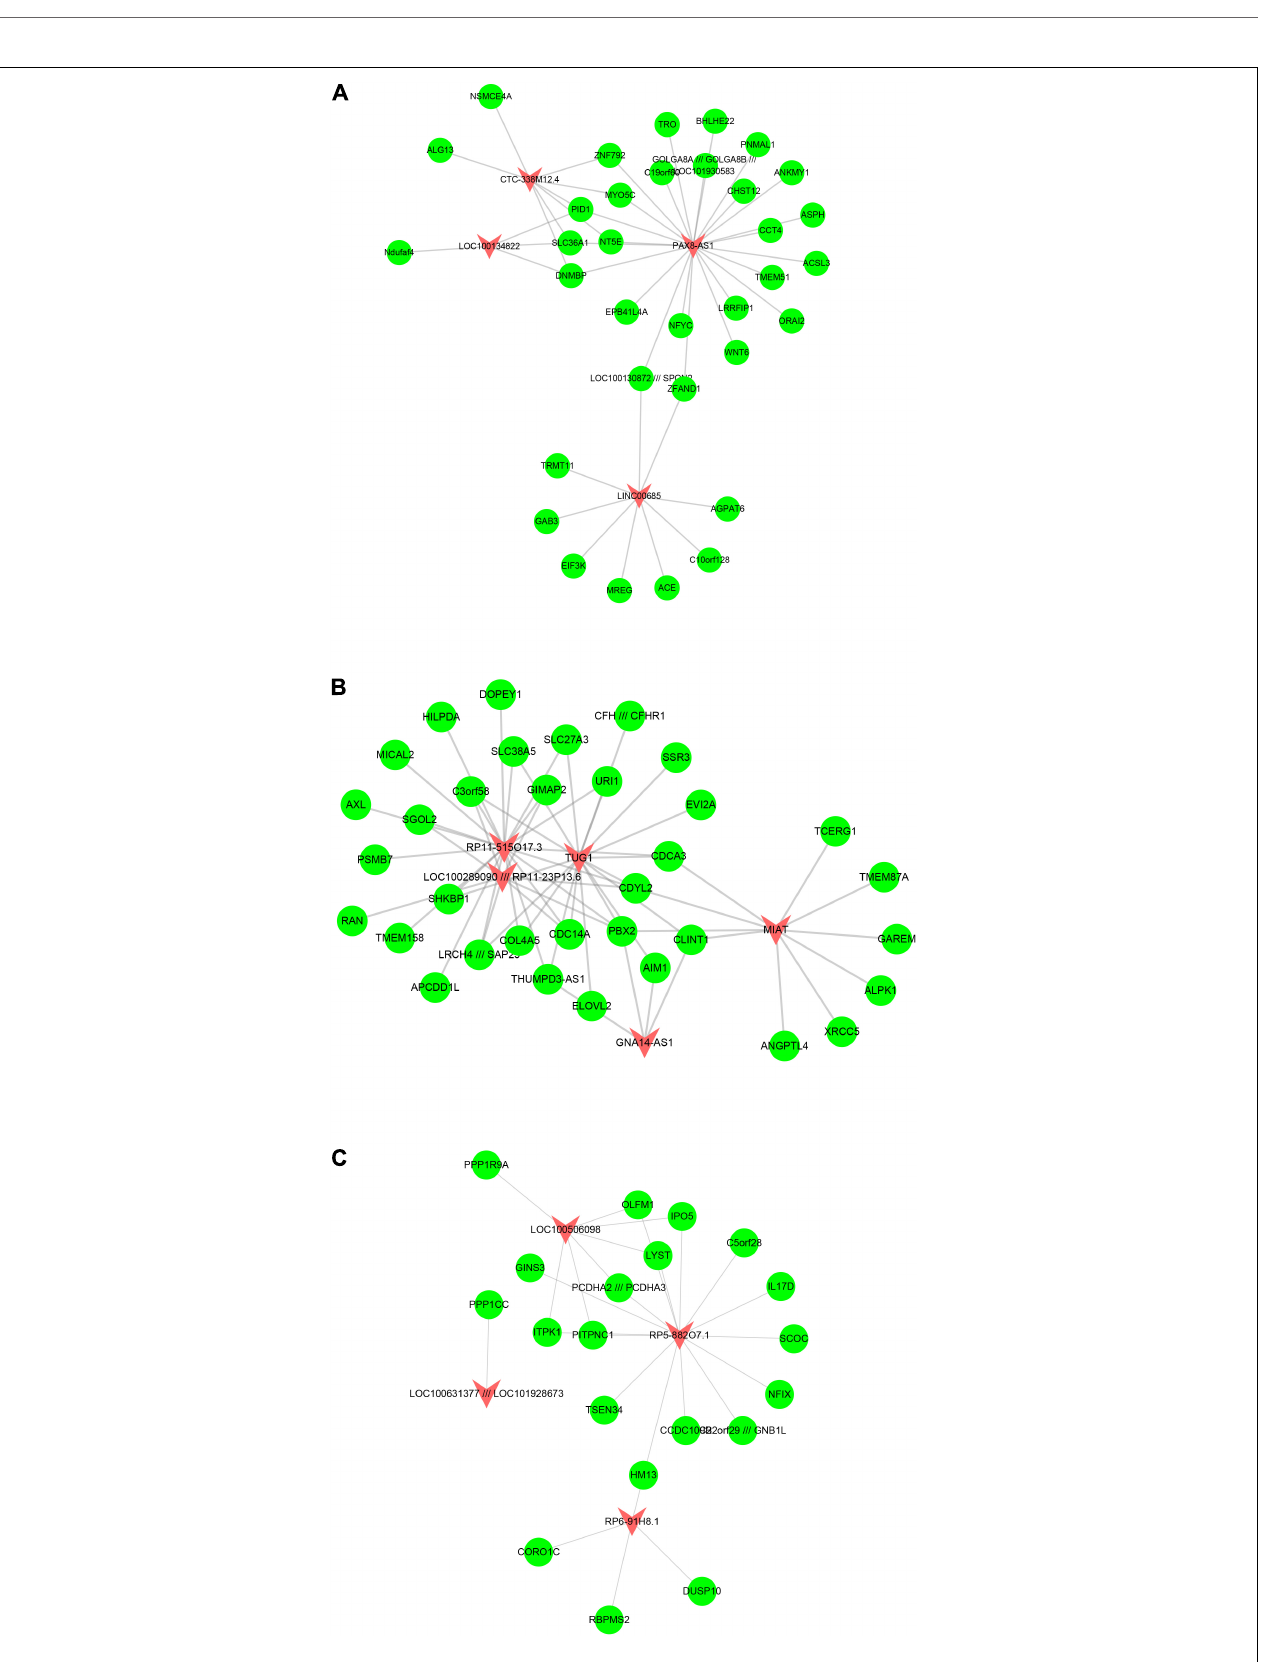
Frontiers in Genetics |